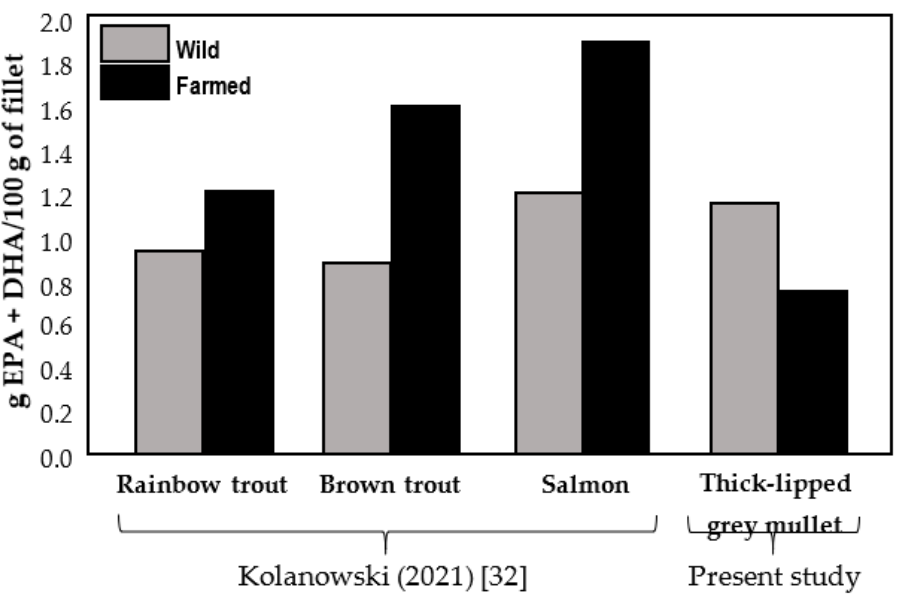
Figure 1. Comparison of content of n-3 long chain PUFAs (g/100 g of raw meat) in wild and cultivated salmonid fish (modified from [32]) and thick-lipped grey mullet fillets (present study). Table 5. Muscle amino acid profile (g 100 g muscle − 1 DW) of wild and cultivated thick-lipped grey